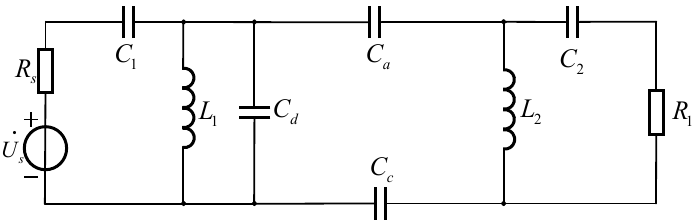
Figure 3. Circuit diagram with single load. Figure 4 can be obtained by Norton’s theorem on the power transmitting side. When the quality factor of the inductor and capacitor is high, the line resistance R s on the power